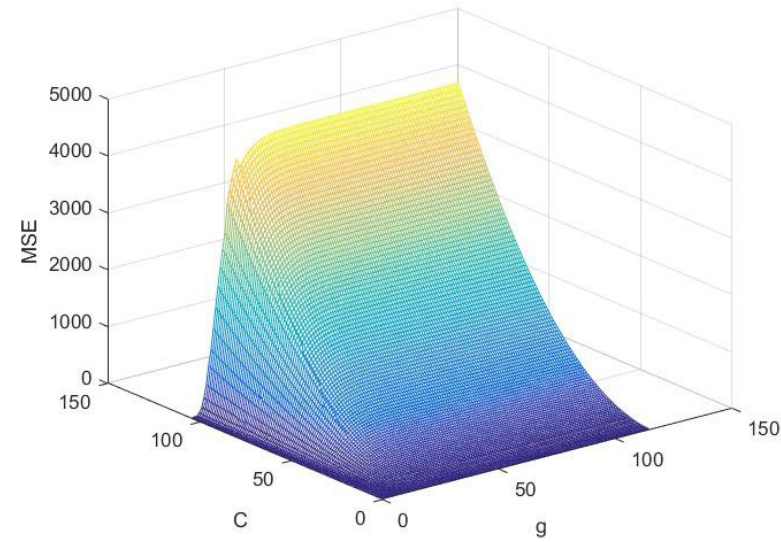
Figure 4. Results of the optimal parameters.